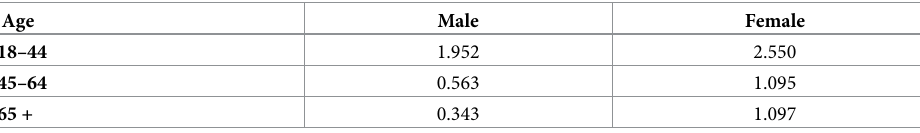
Table 1. Weights applied to each respondent’s answers based on gender and